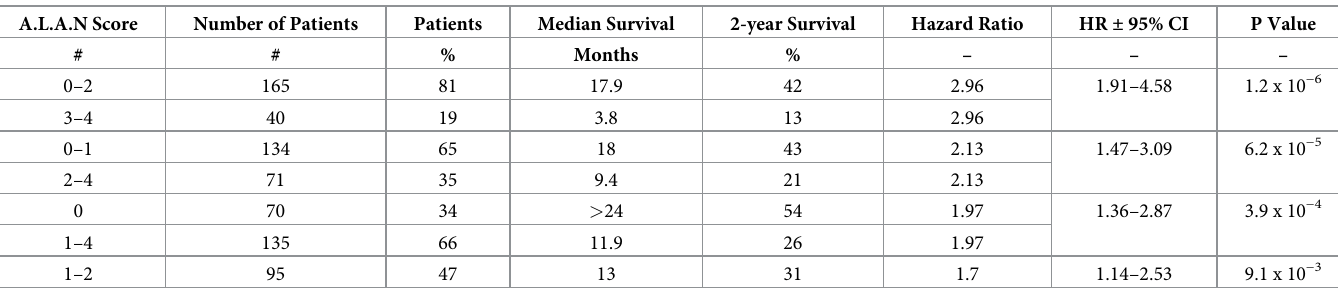
Table 3. Combined A.L.A.N. score GI cancers and survival.